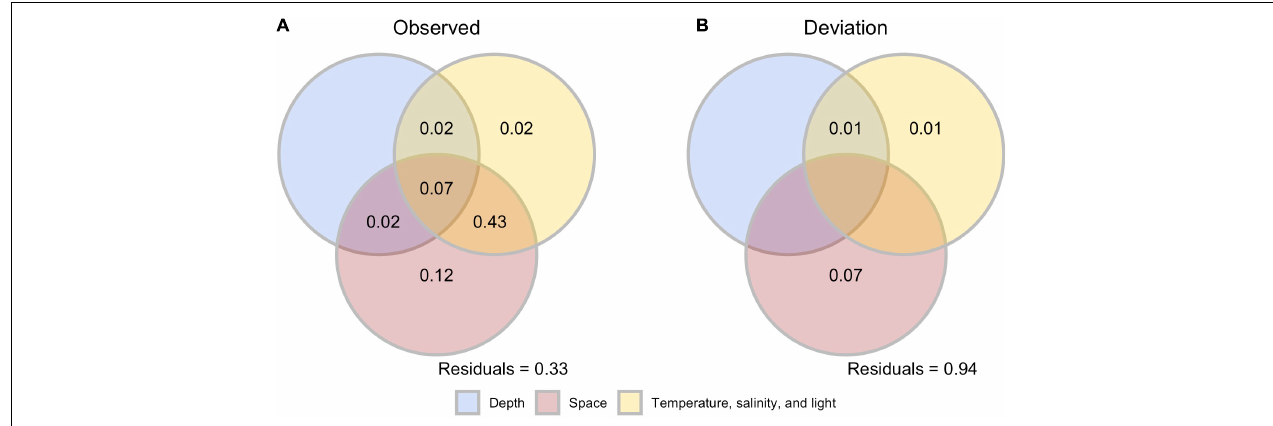
FIGURE 6 | Incidence-based multivariate variance partitioning analyses after db-RDA. The analyses were computed for observed dissimilarities (A) and after controlling for differences in gamma diversity (B) . Numbers in the Venn diagrams are adjusted R 2 that represent the relative contribution of plot-, site-scale, and spatial factors to observed and corrected dissimilarities. See also Supplementary Figure 3